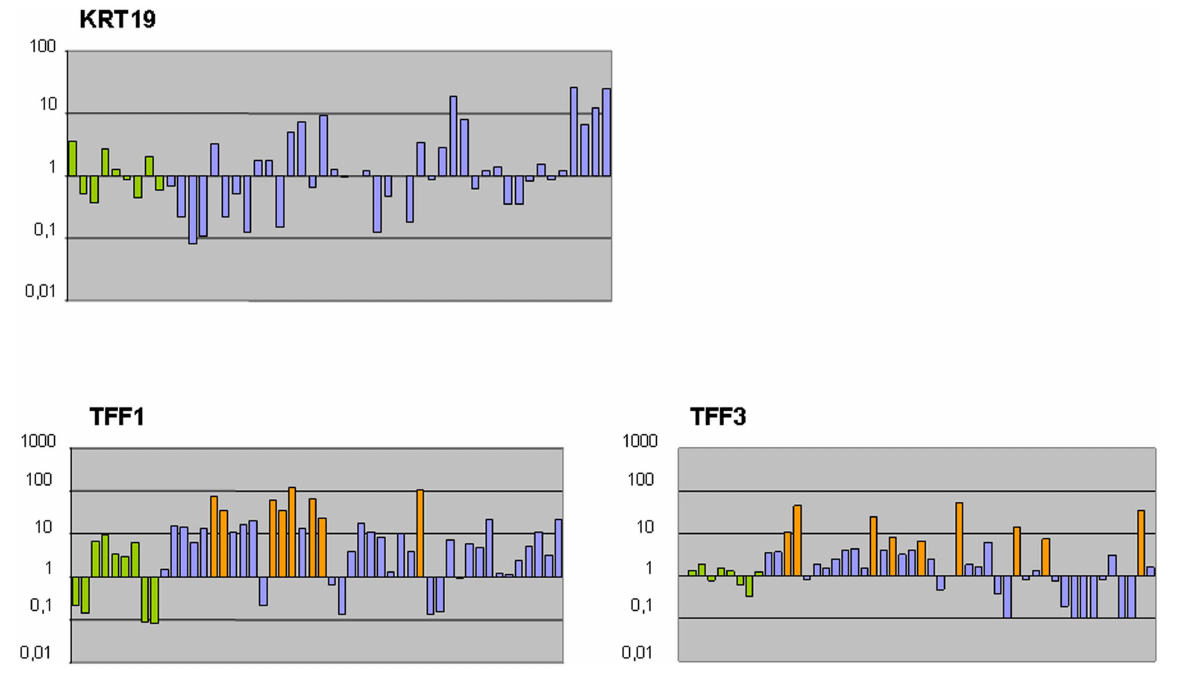
Figure 2. Relative expression of KRT19 , TFF1 and TFF3 . Data were calculated using the DD CT method, whereas the average of healthy controls was used as the calibrator sample (value=1). Green bars indicate the values from nine healthy control samples, purple bars indicate breast cancer samples with no up regulated value and orange bars indicate breast cancer samples over expressing the target gene.